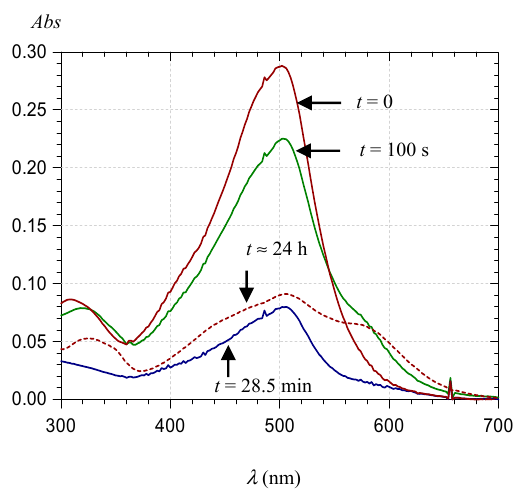
Figure 7. Visible spectra of PA2 (10 µ M) in a pH 5.0 acetate buffer + 12% EtOH at different time ( t ) points.